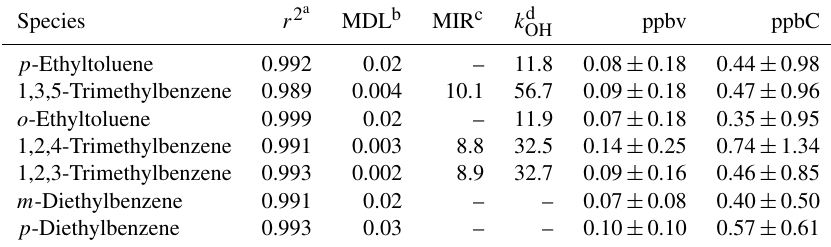
Fig. S3, the trajectories mainly originated from northwest of the sampling site during the whole observation